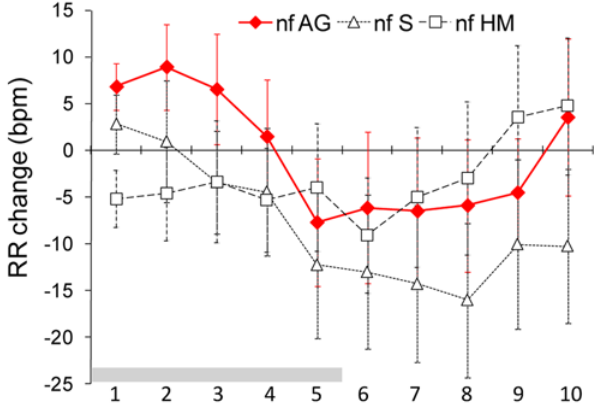
Figure 3. Respiratory rate in response to the odor of areolar secretion, sebum and milk. Mean ( 6 sem) respiratory rate (RR) change of newborns during (2-sec stimulus blocks 1–5) and after (2-sec post-stimulus blocks 6–10) of the presentation of areolar secretions, sebum and human milk (key to abbreviations in legend of Figure 1;